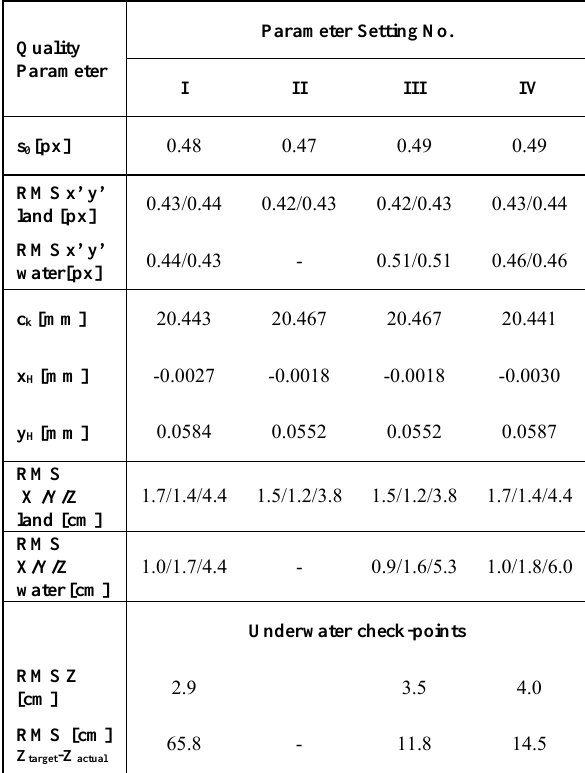
Table 1. Processing-results for different